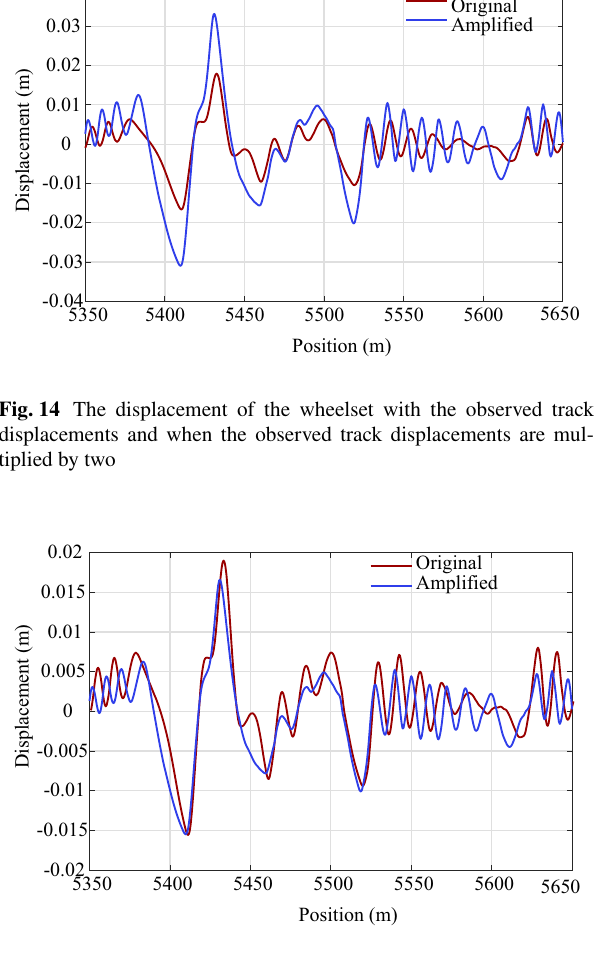
Fig. 15 The normalized displacement of the wheelset when the observed track displacements are multiplied by two. The displace- ment of the wheelset has been “normalized” by dividing all displace- ments by two. This was done in order to ease the comparison between the results of the amplified track and the non-amplified